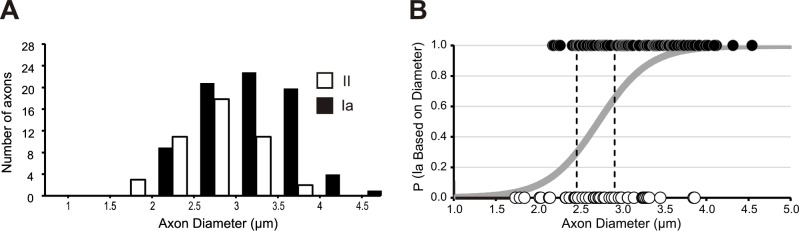
Axon diameter for both morphologically classified spindle afferent subtypes.(A) Histogram of axon diameters for afferents that were classified as primary or secondary endings based on morphological criteria. (B) Logistic regression model used to predict proprioceptive afferent subtypes based on diameter. Black dots represent the diameters of afferents that were classified as primary afferents based on morphologic criteria and therefore they have a 100% probability of being a primary afferent. The open circles illustrate the morphologically classified secondary endings, which have a 0% probability of being a primary ending. The gray line indicates the probability of an afferent being a primary based on diameter. The dotted lines illustrate the cut-off diameters (2.46 and 2.91 μm) for classifying afferents. Axons with diameters left of the first dotted line (diameter < 2.46 μm) were classified as group II afferents, axons with diameters between the dotted lines could not be classified based on diameter alone, and axons with diameters to the right of the second dotted line (diameter > 2.91 μm) were classified as Ia afferents.